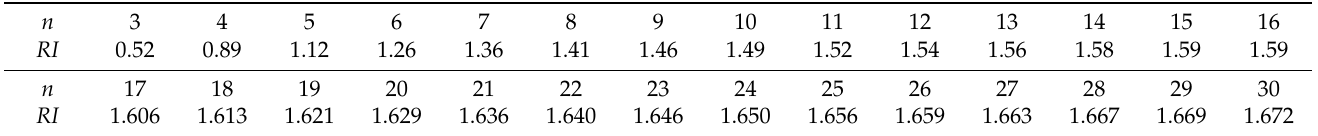
Table 5. Random consistency RI